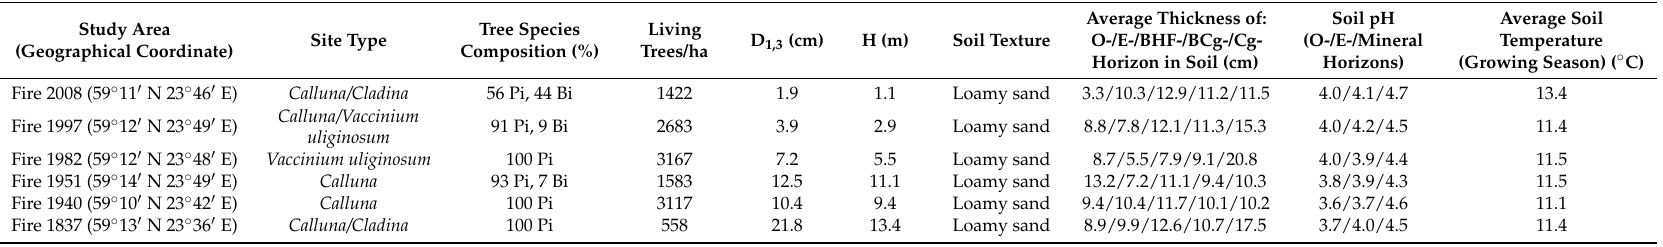
Table 1. Stand and soil characteristics of the study areas. Pi—Scots pine, Bi—Birch. Geographical coordinate represent the location of middle sample plot in a fire